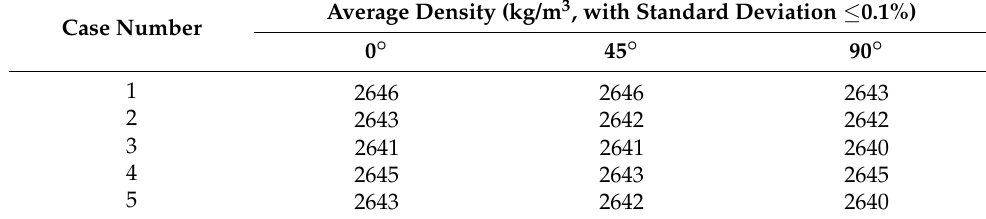
Table 3. Average density of specimens in each case according to polar angle.